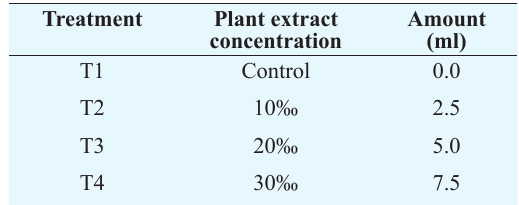
Table 2. Dosages used to determine the effect of each foliar extract on Coffea arabica ‘Caturra